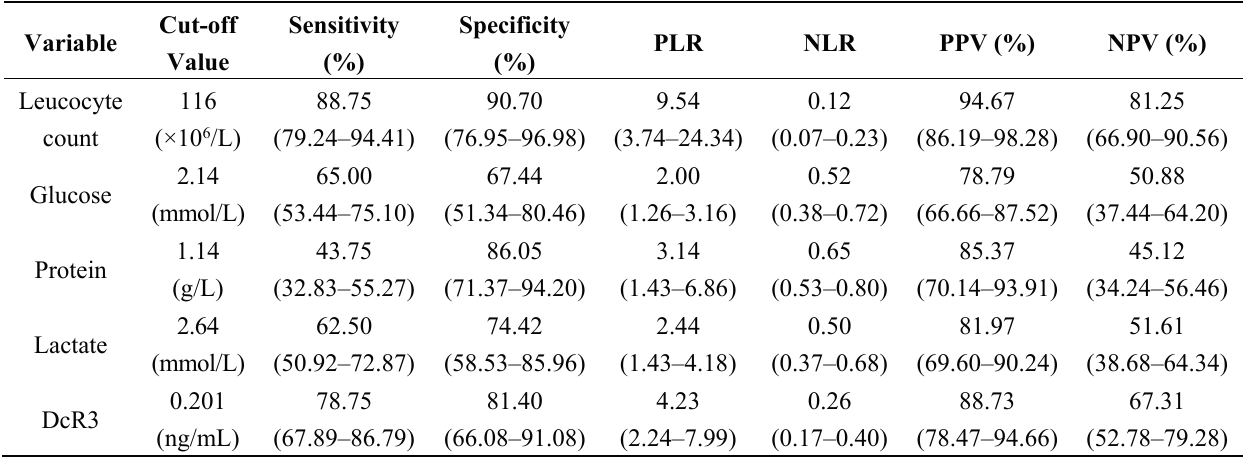
Table 2. Diagnostic values of DcR3 and CSF markers for the diagnosis of bacterial meningitis. Variable